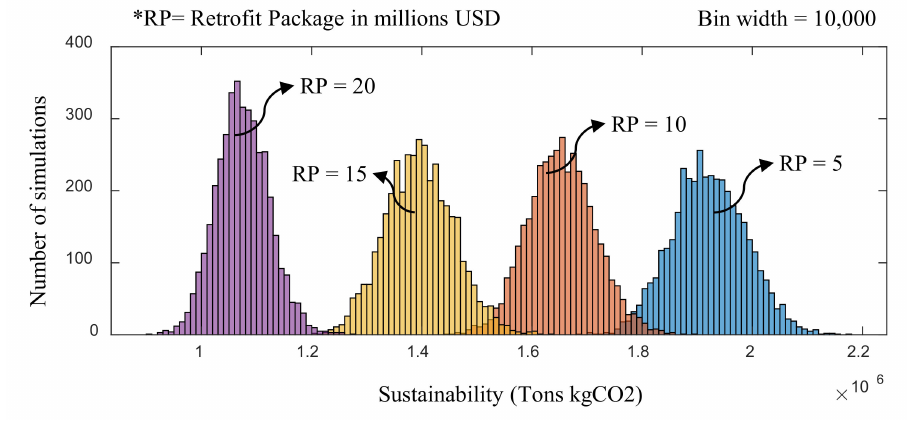
Figure 15. Distributions of sustainability performance indicator under four retrofit programs. Table 2. Statistical moments of risk performance indicator under considered retrofit